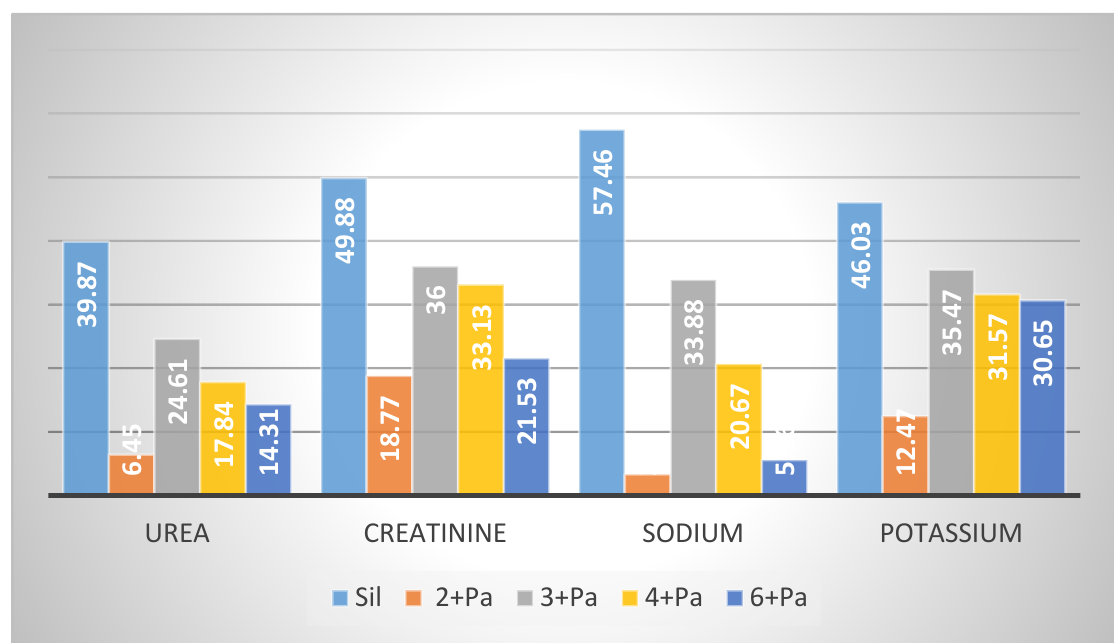
Figure 6. Effect of compounds 2–4 , 6 on kidney serum biochemical parameters (% reduction).